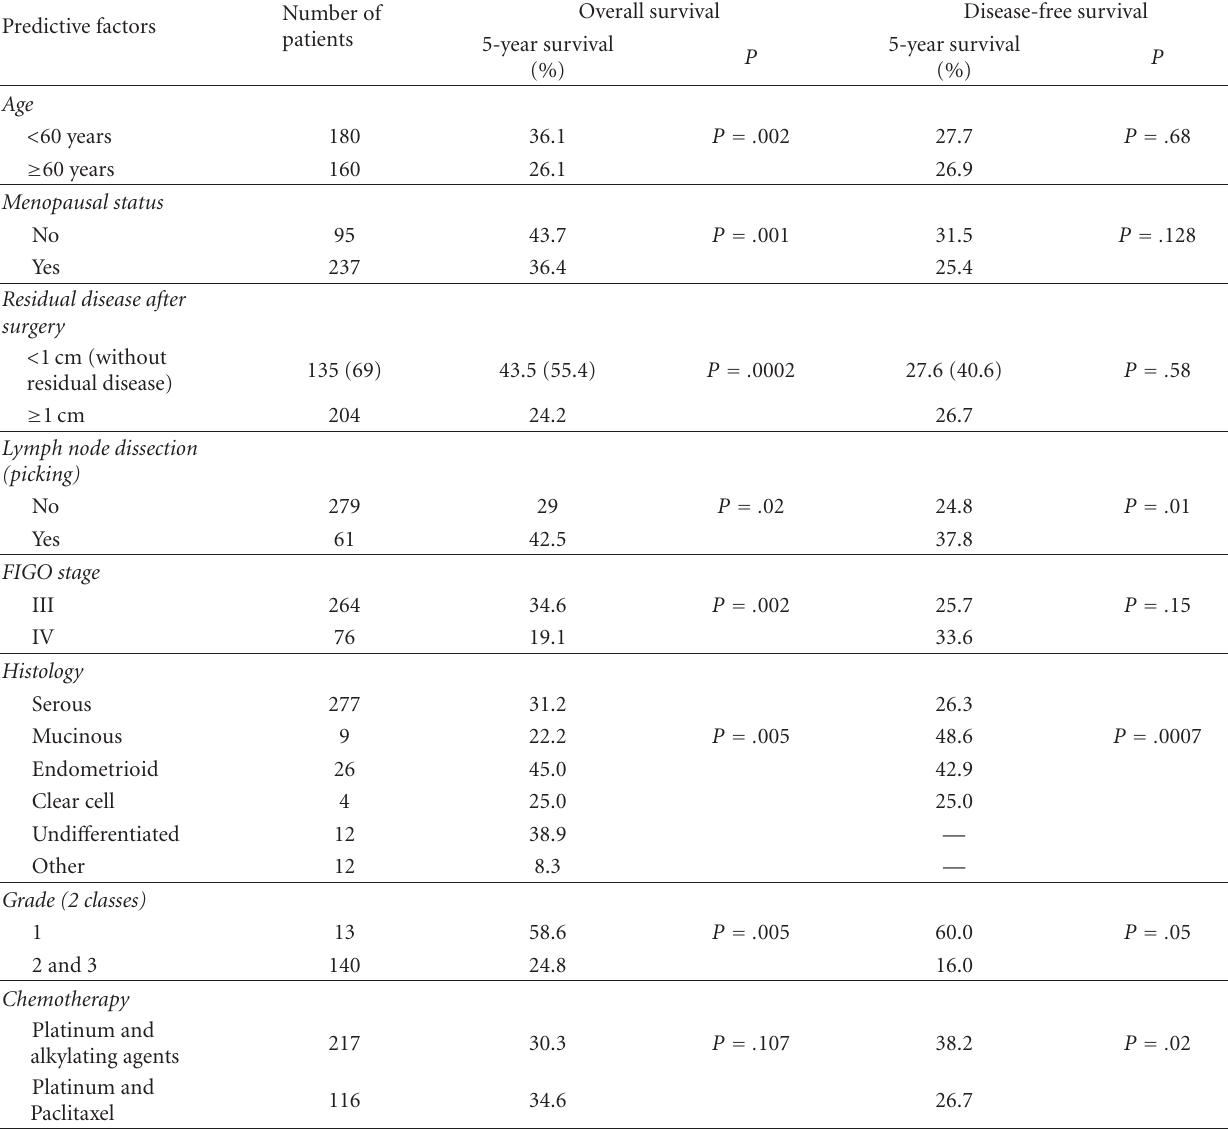
Table 2: Predictive factors of